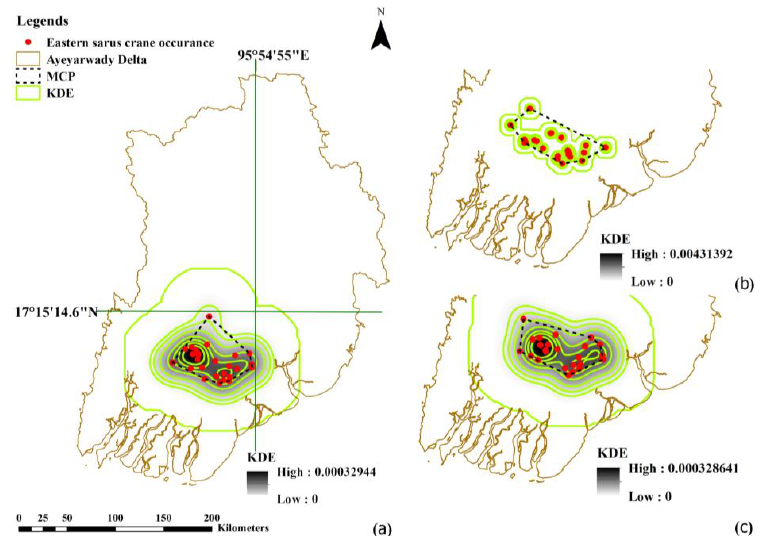
Figure 7. The response of eastern sarus crane ( Antigone antigone sharpii ) to land covers in Ayeyarwady Delta, the Union of Myanmar in ( a ) the summer season, ( b ) the rainy season, and ( c ) the winter season; 1 = perennial water, 2 = impervious surface, 3 = villages, 4 = croplands, 5 = man- aged forests, 6 = natural forests, 7 = ephemeral water, 8 = depressions, 9 = shrub and grass, and 10 = bare surfaces; the red indicate the mean values, the blue (positive) and the green (negative) denote the one standard deviation limits, resulting from cross validation model runs.